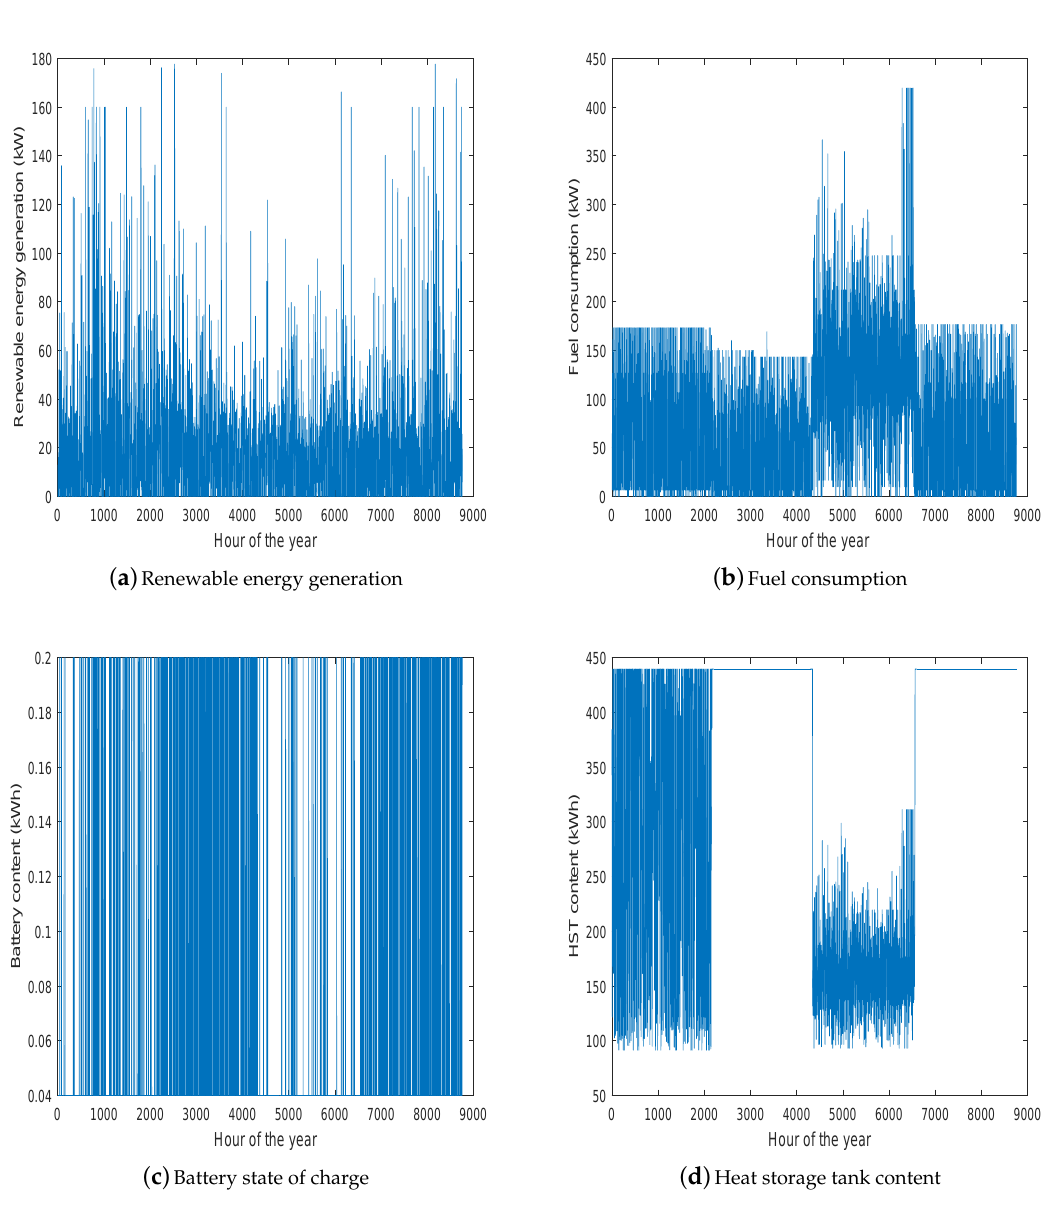
Figure 13. RECCHP in